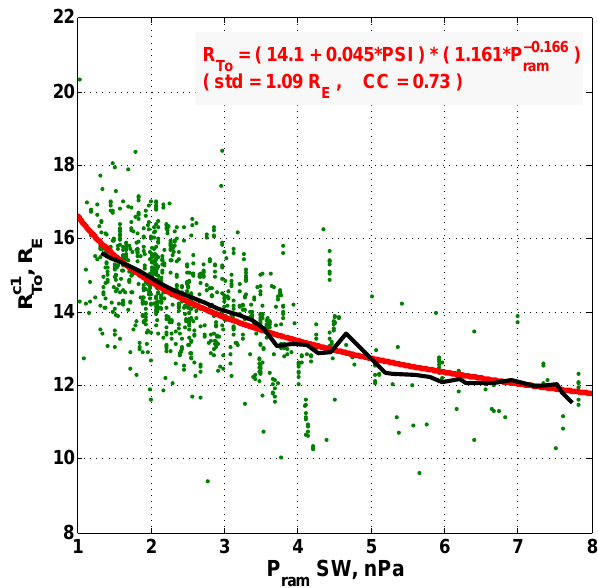
Figure A2. The relationship between solar wind dynamic pressure and terminator radius with subtracted dipole tilt dependence. The red curve is the regression line corresponding to Eq. (A4). The black line is the moving average (with the window size 1nPa, step size